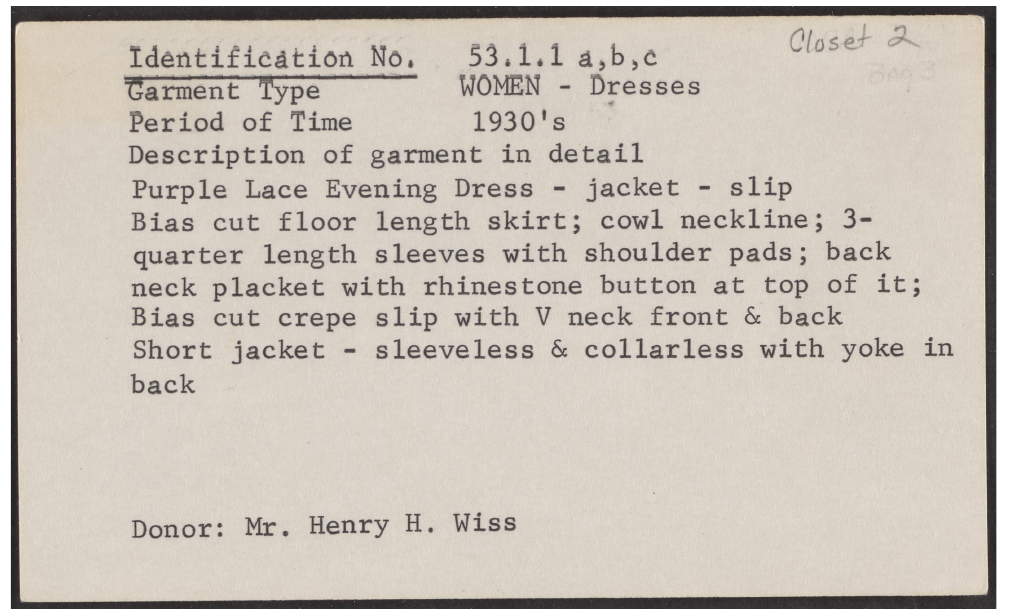
Figure 2 : Example notecard from the garment